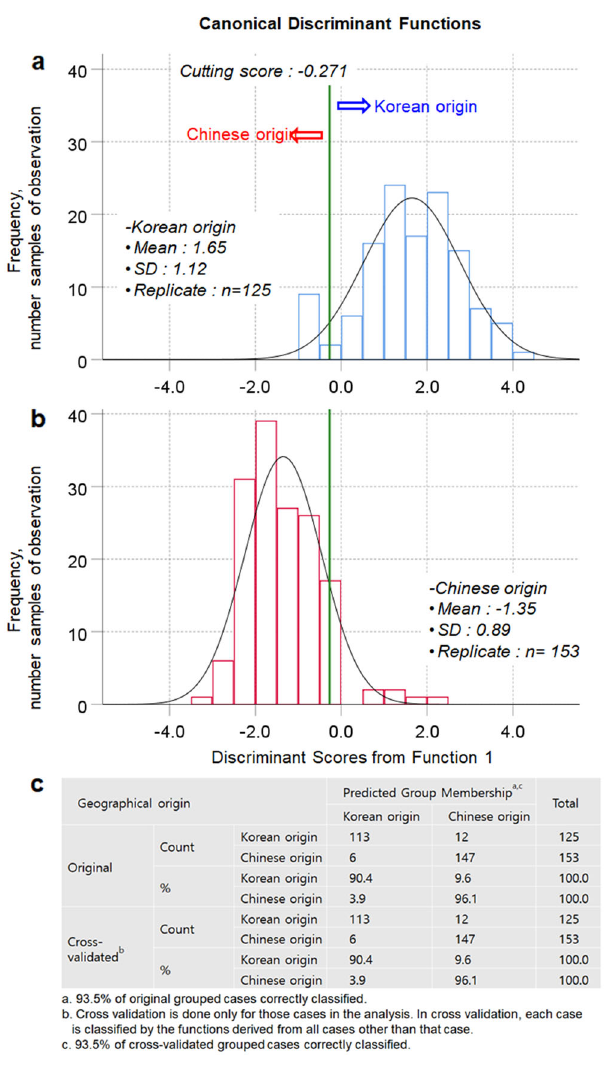
Fig. 4 Discriminant analysis for the geographical identi fi cation of shiitake mushrooms produced using Chinese inoculated sawdust blocks, when considered as having a Chinese origin. a Discrimi- nant scores for shiitake mushrooms with a Korean origin, b Discriminant scores for shiitake mushrooms with a Chinese origin, and c Classi fi cation and cross-validated results of the geographical origin of shiitake mushrooms.